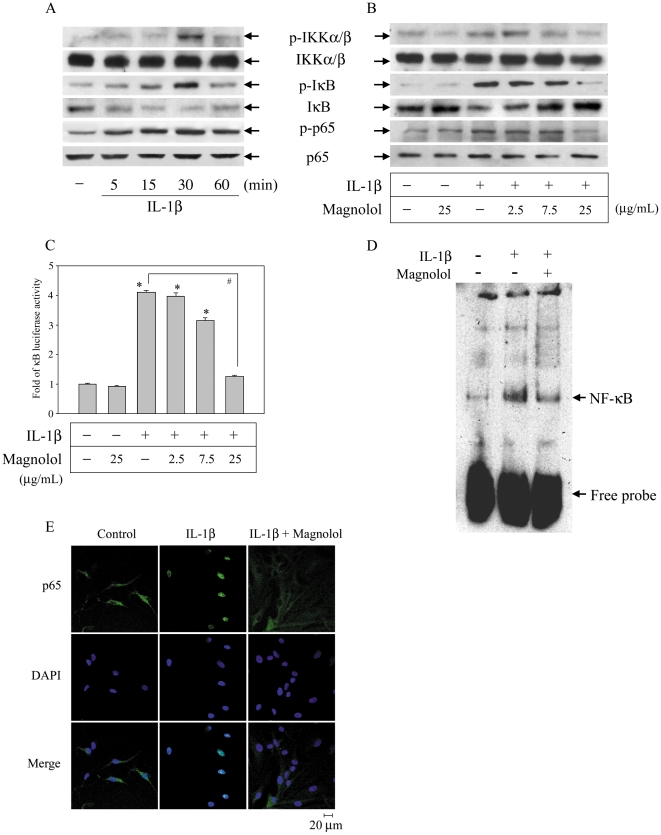
Magnolol inhibits NF-κB activation in IL-1β-stimulated FLS.FLS (1×106 cells) were treated with or without 10 ng/mL of IL-1β for the indicated times (A) or were treated with 0–25 µg/mL of magnolol for 30 min, then stimulated with 10 ng/mL IL-1β for 30 min in the continued presence of magnolol (B), then the cells were harvested and whole cell extracts subjected to Western blot analysis for the indicated proteins. (C) Cells (1×105 cells) were transiently transfected with 1 µg of pGL4.32[luc2P/NF-κB-RE/Hygro] for 24 h and treated with 0–25 µg/mL magnolol for 30 min prior to stimulation with 10 ng/mL of IL-1β in the continued presence of magnolol for a further 6 h, then luciferase activity was measured as described in the Materials and Methods. The results are expressed as the mean ± standard error of the mean (SEM), with n = 3. * p<0.05 compared to the control group; #p<0.05 for comparison of indicated groups. (D) FLS were incubated with vehicle or 10 ng/mL of IL-1β or were pretreated with 25 µg/mL of magnolol for 30 min, then incubated with IL-1β in the continued presence of magnolol for 1 h, then the DNA binding activity of the nuclear extracts was examined in an electrophoretic mobility shift assay using a specific NF-κB DNA probe. (E) Cells (1×105 cells) were left untreated or were treated with 25 µg/mL of magnolol for 30 min, then stimulated with 10 ng/mL of IL-1β in the continued presence of magnolol for 1 h, when samples were prepared for confocal microscopy analysis. Scale bar = 20 µm.